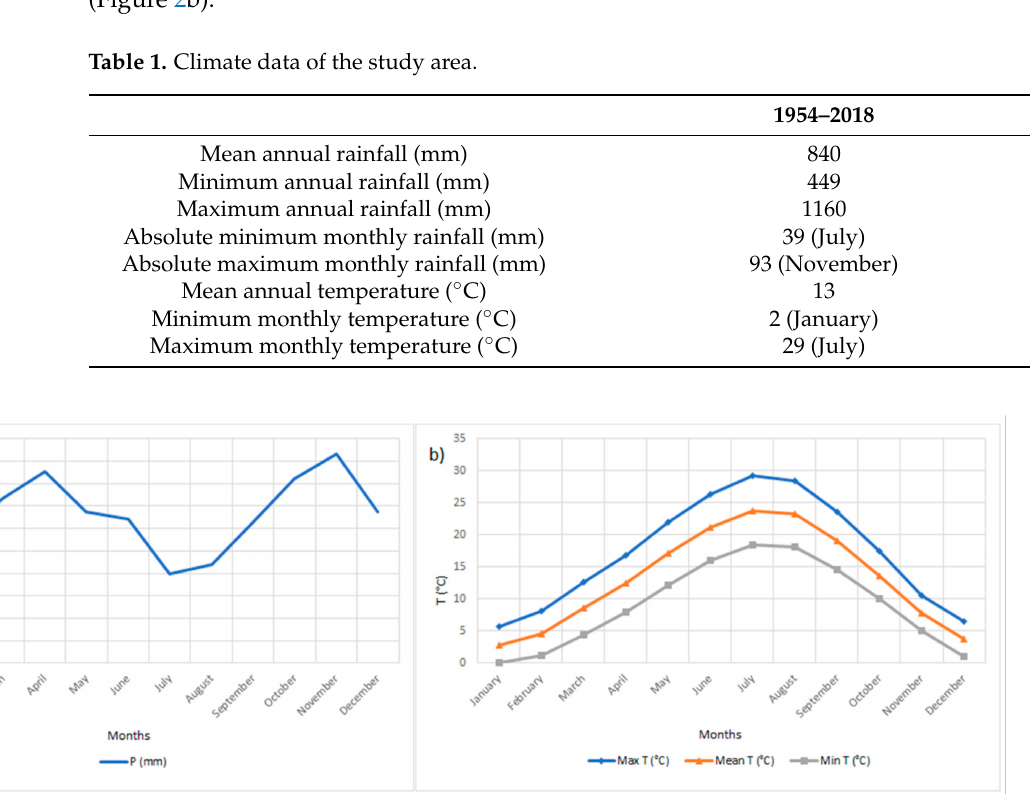
Figure 2. ( a ) Average monthly precipitation for the study area; ( b ) average monthly maximum, minimum and mean temperature of